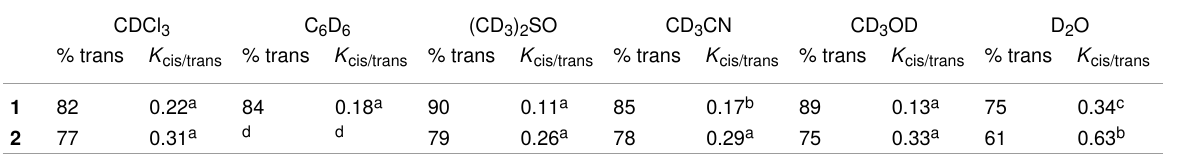
Table 3: Average trans rotamer proportions (% trans ) and K cis/trans values in peptoids 1 and 2 , calculated from the integration of 1 H NMR spectra in various solvents (8 mM).